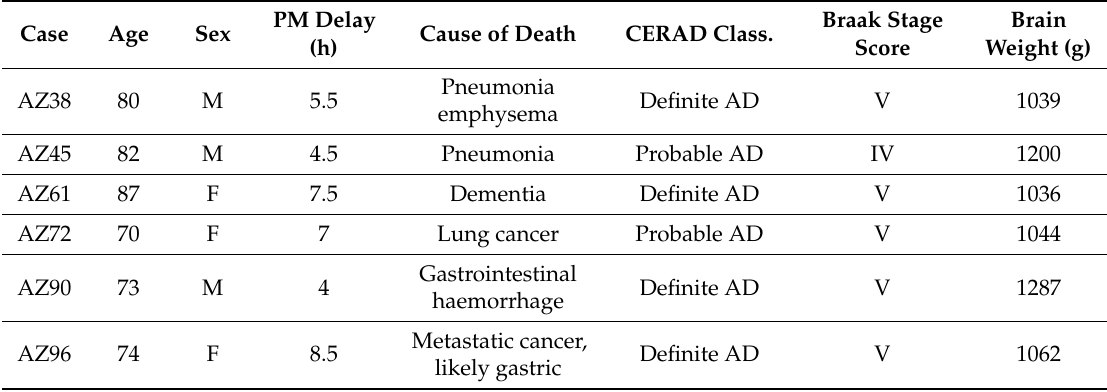
Table 2. Details of Alzheimer’s disease cases for NanoString nCounter Study.